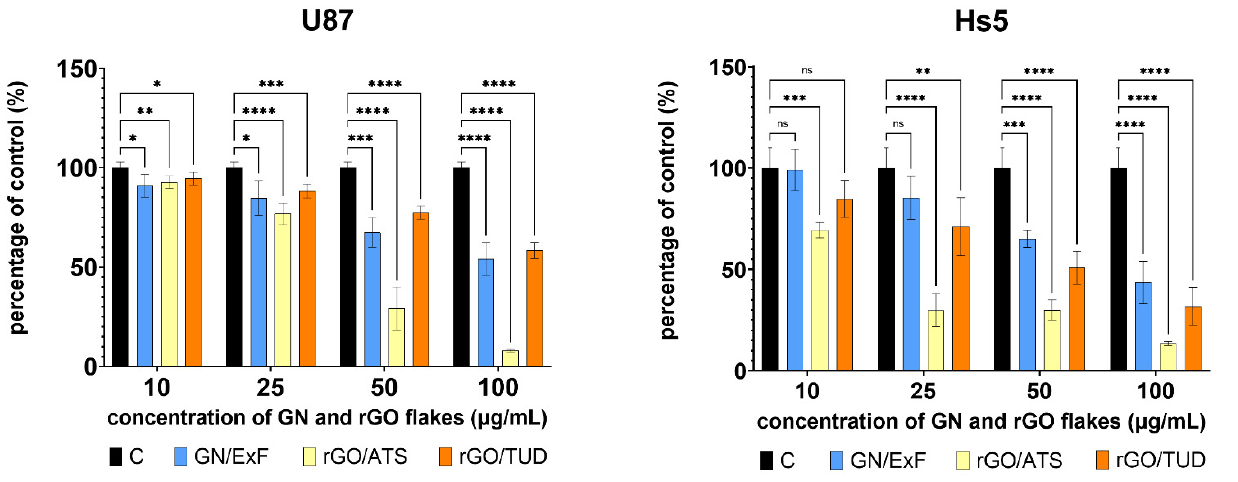
Figure 2. Cell viability of U87 and Hs5 cells treated and untreated with GN and rGO flakes, as evaluated by the neutral red assay. U87 and Hs5 cells were exposed to GN and rGO flakes at concentrations of 10, 25, 50, and 100 µ g/mL for 24 h. Values are expressed as mean ± standard deviation. Statistical significance between the control and treated cells is indicated by an asterisk and was assessed using Bonferroni’s multiple comparison test. Differences with p < 0.05 were considered statistically significant. One asterisk (*) indicates p < 0.01, two asterisk (**) indicates p < 0.005, three asterisks (***) indicate p < 0.001, four asterisk (****) indicate p < 0.0001. Abbreviations: rGO, reduced graphene oxide; GN, graphene; C, control group (untreated group); ExF, exfoliation; ATS, ammonium thiosulphate; TUD, thiourea dioxide; ns, not significant .